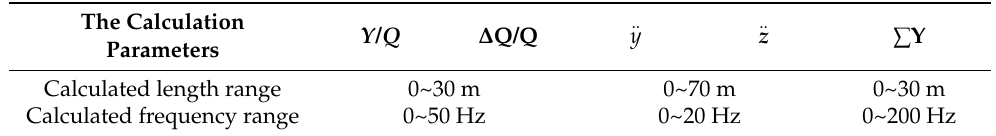
Table 2. The calculation parameters for the